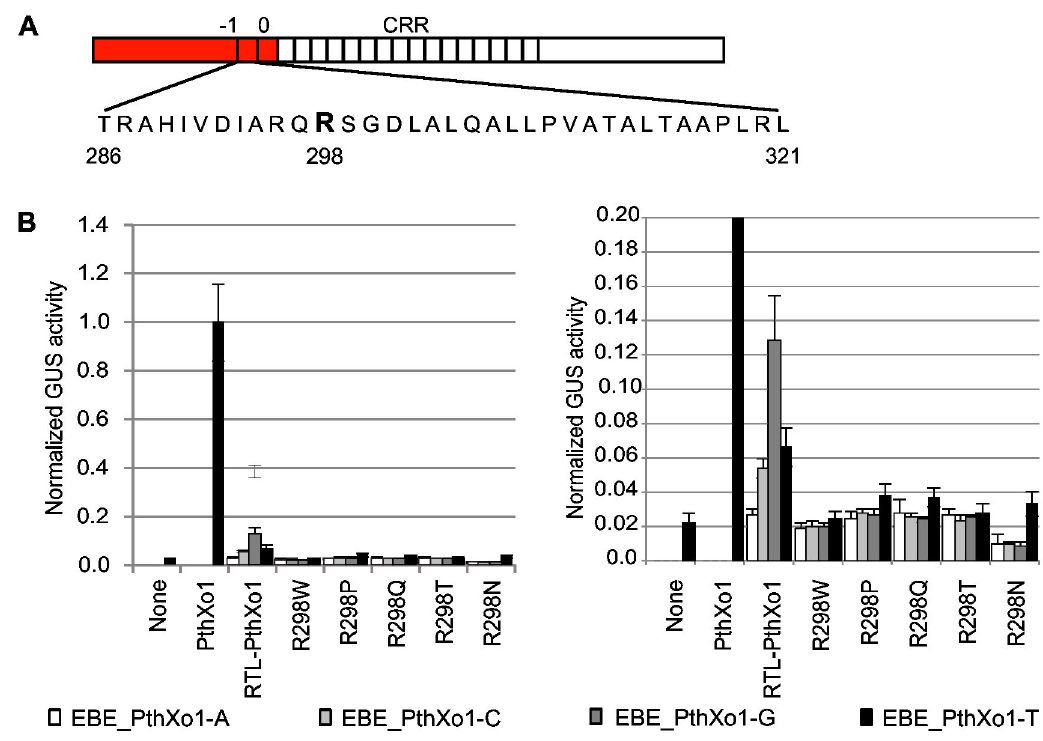
Figure 5. Activity of chimeric TAL effector RTL-PthXo1 with single amino acid substitutions for R298 on targets with A, C, G, or T at the 0 th position. A. Schematic of the chimeric TAL effector RTL-PthXo1 with the -1 st and 0 th repeats and the central repeat region (CRR) labeled, and showing the RSc1815 -1st repeat sequence. RTL-PthXo1 was created by replacing the N terminal region immediately upstream of the CRR of our PthXo1 construct with the N terminal region of RTL RSc1815 (shown in red). The arginine (R) in the RTL that aligns to W232 is shown in large bold font. Numbers indicate positions in the RTL sequence. B. Left, activity of RTL-PthXo1 with the native arginine at position 298 (R298) and of variants with selected amino acid substitutions at that position (as labeled), measured in an Agrobacterium -mediated transient expression assay in Nicotiana benthamiana leaves, using a GUS reporter gene cloned downstream of a minimal promoter (see Materials and Methods) containing the PthXo1 EBE with the 0 th position thymine (EBE_PthXo1-T), or variants with adenine, cytosine, or guanine as base 0 (EBE_PthXo1-A, EBE_PthXo1-C, and EBE_PthXo1-G, and respectively). Right, the same plot at a larger scale. Activity is normalized to the activity of PthXo1 on EBE_PthXo1-T, set to 1.0. Values are the mean of five replicates. Error bars represent s.d. See Table S9 for p-values. Experiments were repeated at least twice with similar